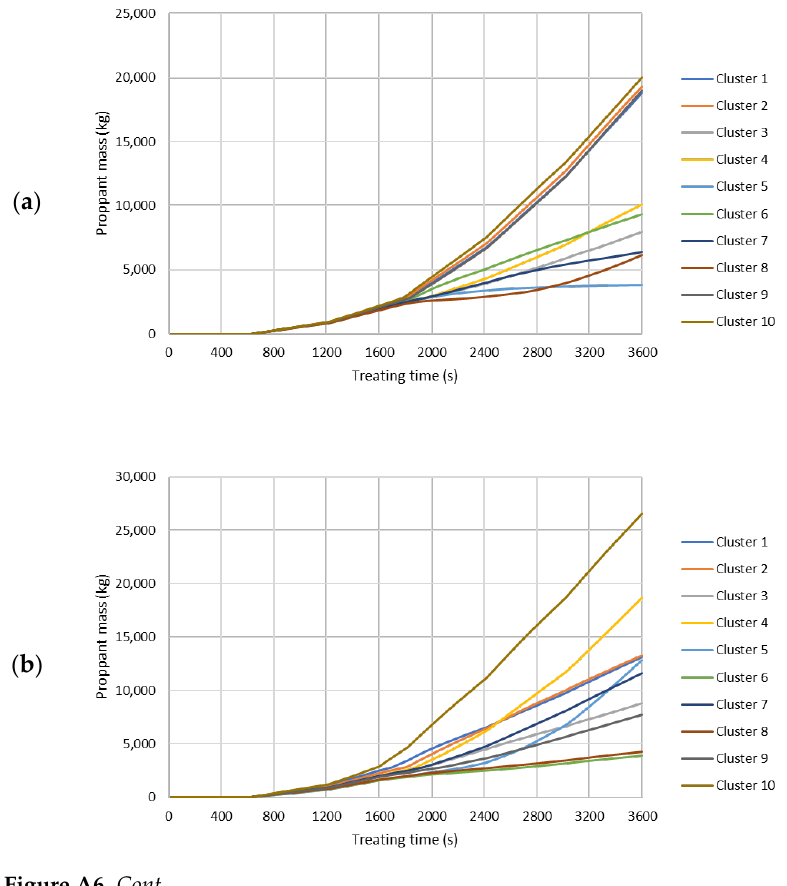
Figure A5. Fracture volume of each cluster during the hydraulic fracturing treatment. ( a ) Slick water case. ( b ) NG foam case. ( c ) Hybrid NG/NG foam case.